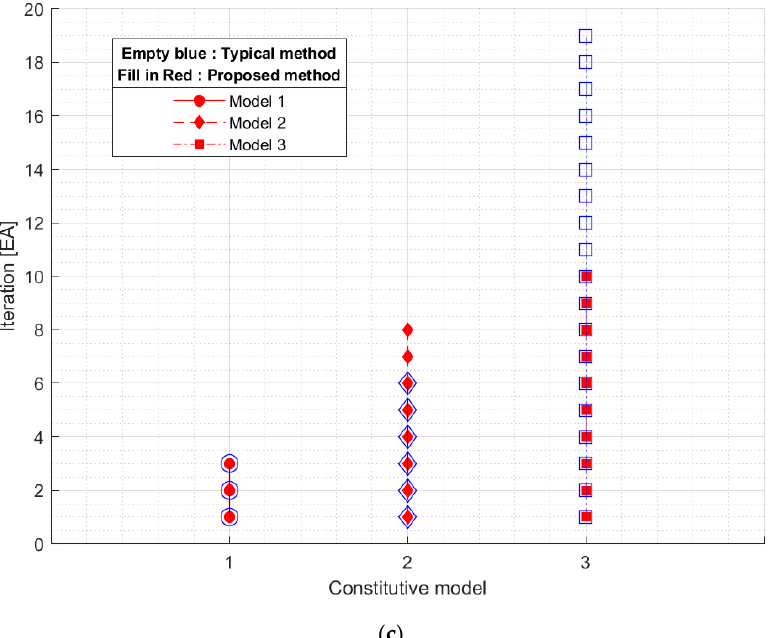
Figure 14. Convergence process of inverse method. ( a ) Constitutive model vs RMSE; ( b ) Iteration vs RMSE; ( c ) Constitutive model vs Iteration.